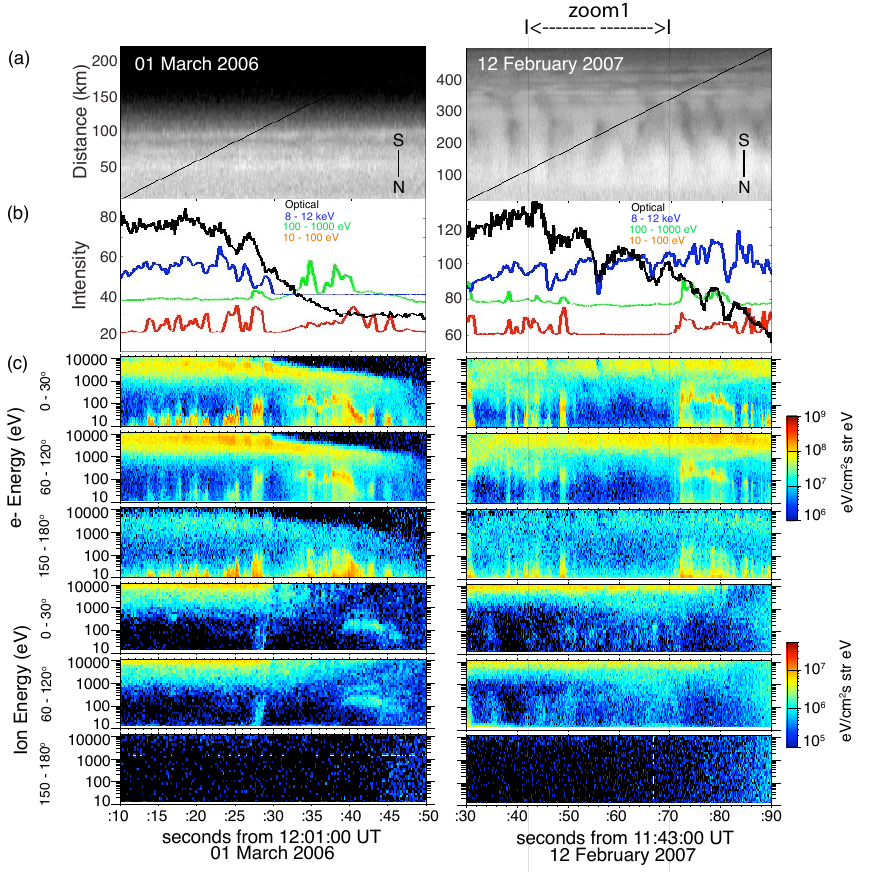
Fig. 2. Overview of data for 2 overpasses: Left column: 1 March 2006, Right column: 12 February 2007. (a) Keogram of auroral intensity along the Reimei footpoint (North at the bottom, South at the top). The distance along the satellite track, assuming 100km altitude, is along the y-axis and time is along the x-axis. The diagonal black line represents the location of the satellite footpoint at that time. (b) Black line: intensity at the footpoint location extracted from the optical signature. Three coloured lines: Summed flux of the downgoing electrons over the noted energy ranges, scaled for comparison. (c) Ion and electron data from the Reimei satellite. Zoom1 denotes one of the specific time periods shown in Fig.